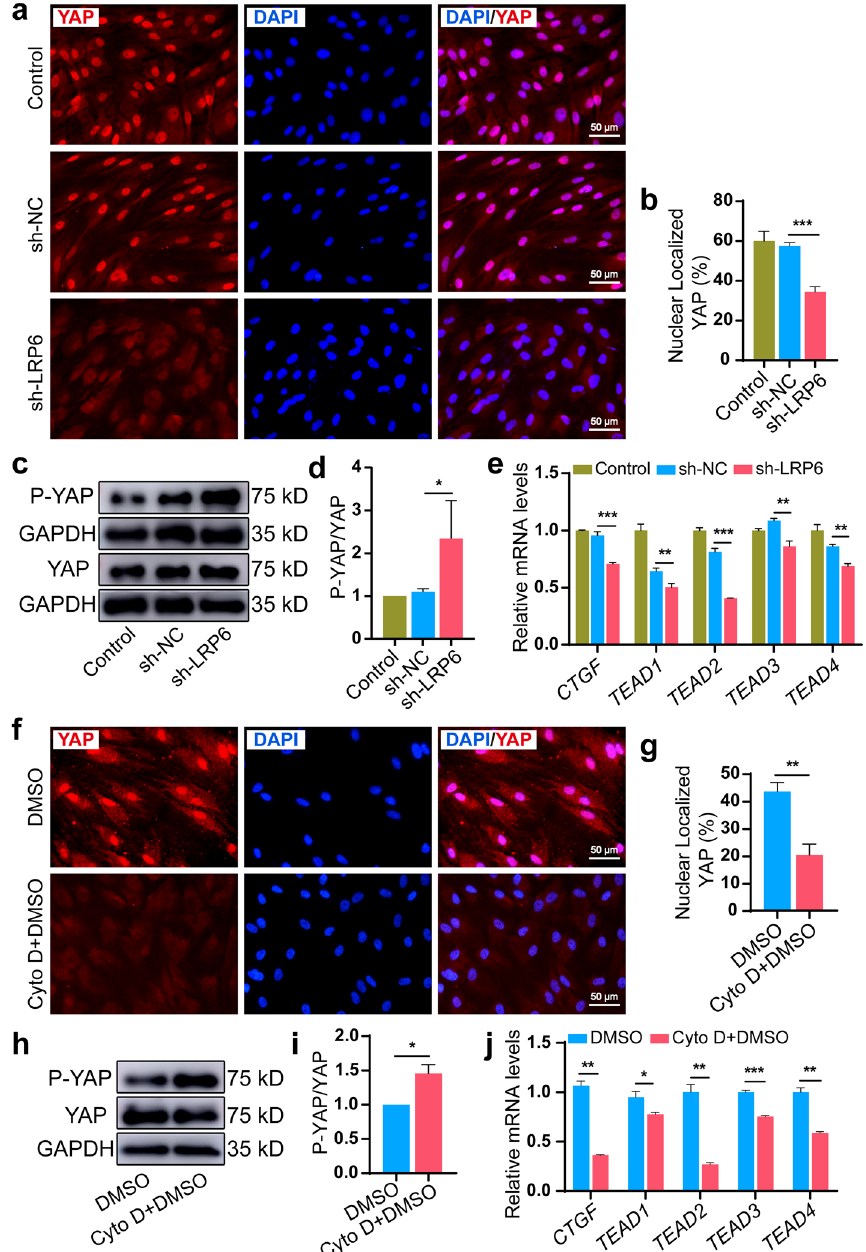
Fig. 5 LRP6/F-actin axis modulated YAP nuclear translocation and activation in force-induced PDLSCs. a , b Immunofluorescence and semi-quantitative analysis of YAP nuclear localization in the control, sh-NC, and sh-LRP6 group after stretching for 24 h. Scale bar, 50 μm. c , d Western blotting analysis indicated the ratio of P-YAP/total-YAP in the control, sh-NC, and sh-LRP6 group after stretching for 24 h. e The mRNA levels of YAP target genes ( CTGF , TEAD1 , TEAD2 , TEAD3 , TEAD4 ) in the control, sh-NC, and sh-LRP6 group after stretching for 24 h. f , g Immunofluorescence and semi-quantitative analysis of YAP nuclear localization in the DMSO and Cyto D DMSO groups after stretching for 24 h. Scale bar, 50 μm. h , i Western blotting analysis indicated + the ratio of P-YAP/total-YAP in the DMSO and Cyto D DMSO groups after stretching for 24 h. j The mRNA + levels of YAP target genes ( CTGF , TEAD1 , TEAD2 , TEAD3 , TEAD4 ) in the DMSO and Cyto D DMSO groups + after stretching for 24 h. * P < 0.05, ** P < 0.01, *** P < 0.001. Results are presented as mean SD of triplicated ±